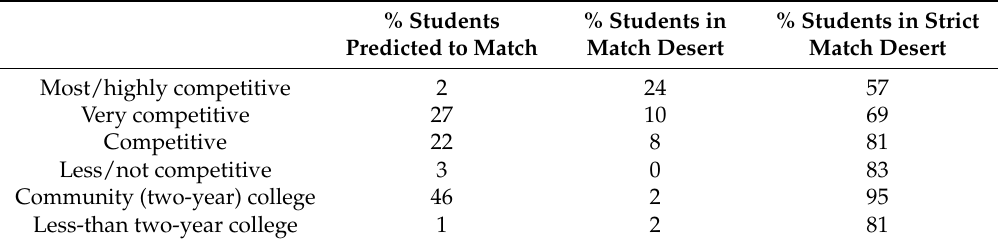
Table 2. Percent of students who matched at each selectivity level, and the percent who match at each level who live in a match desert. % Students % Students in % Students in Strict Predicted to Match Match Desert Match Desert Most/highly competitive 2 24 57 Very competitive 27 10 69 Competitive 22 8 81 3